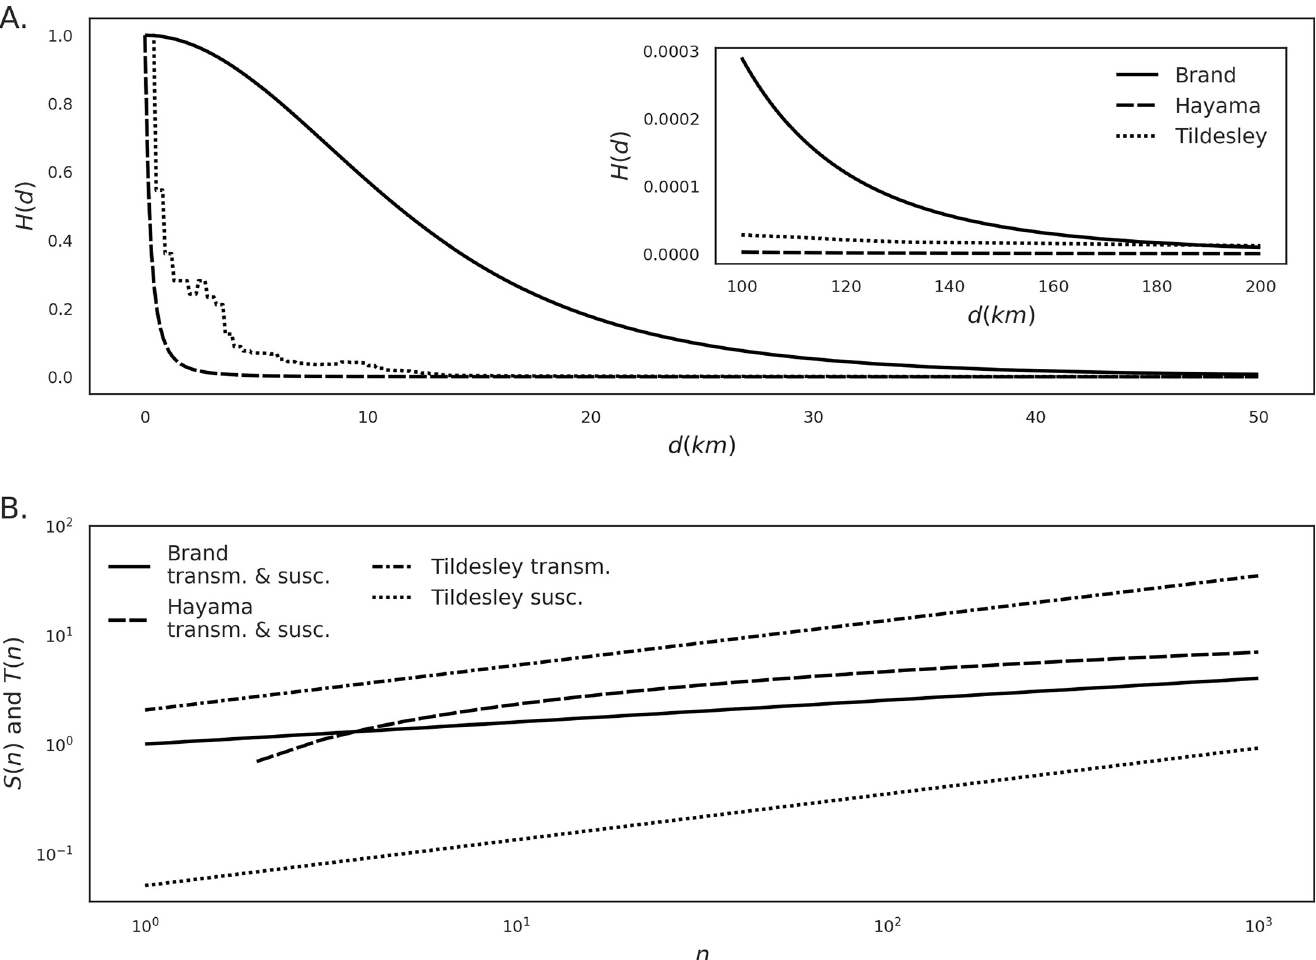
Fig 3. Functional forms of the distance kernel H as a function of the distance in kilometers (A), and transmissibility ( T ) and susceptibility ( S ) as functions of herd size ( n , panel B). To enable comparison, the kernels have been scaled (for the purpose of this plot only) so that H(0) = 1 . 0